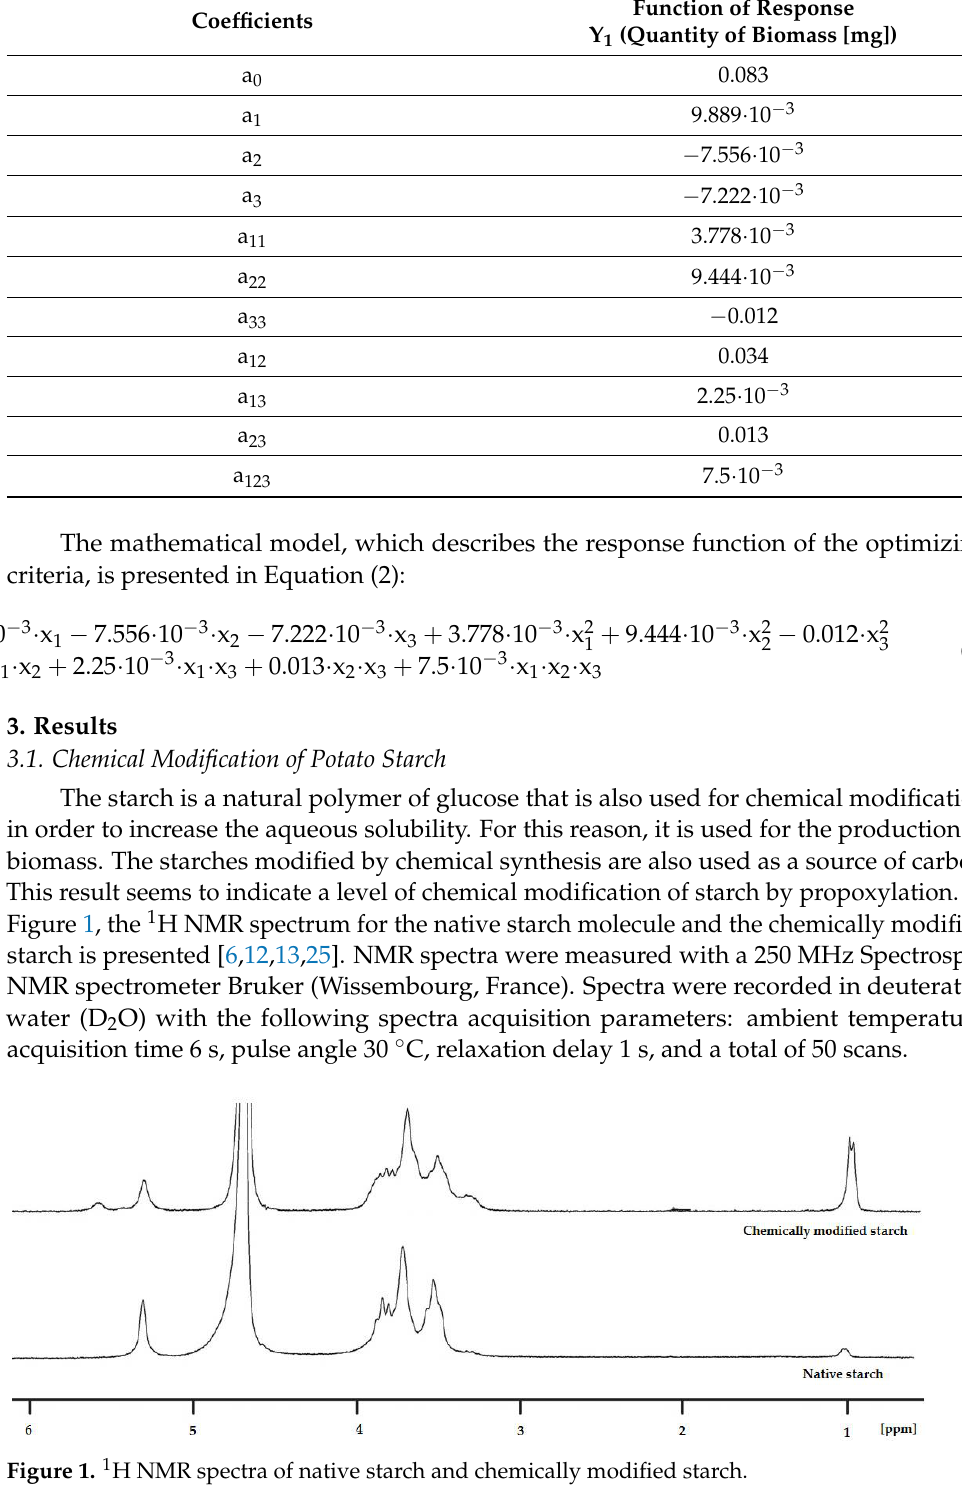
Table 4. Values of the coefficients for the regression function.